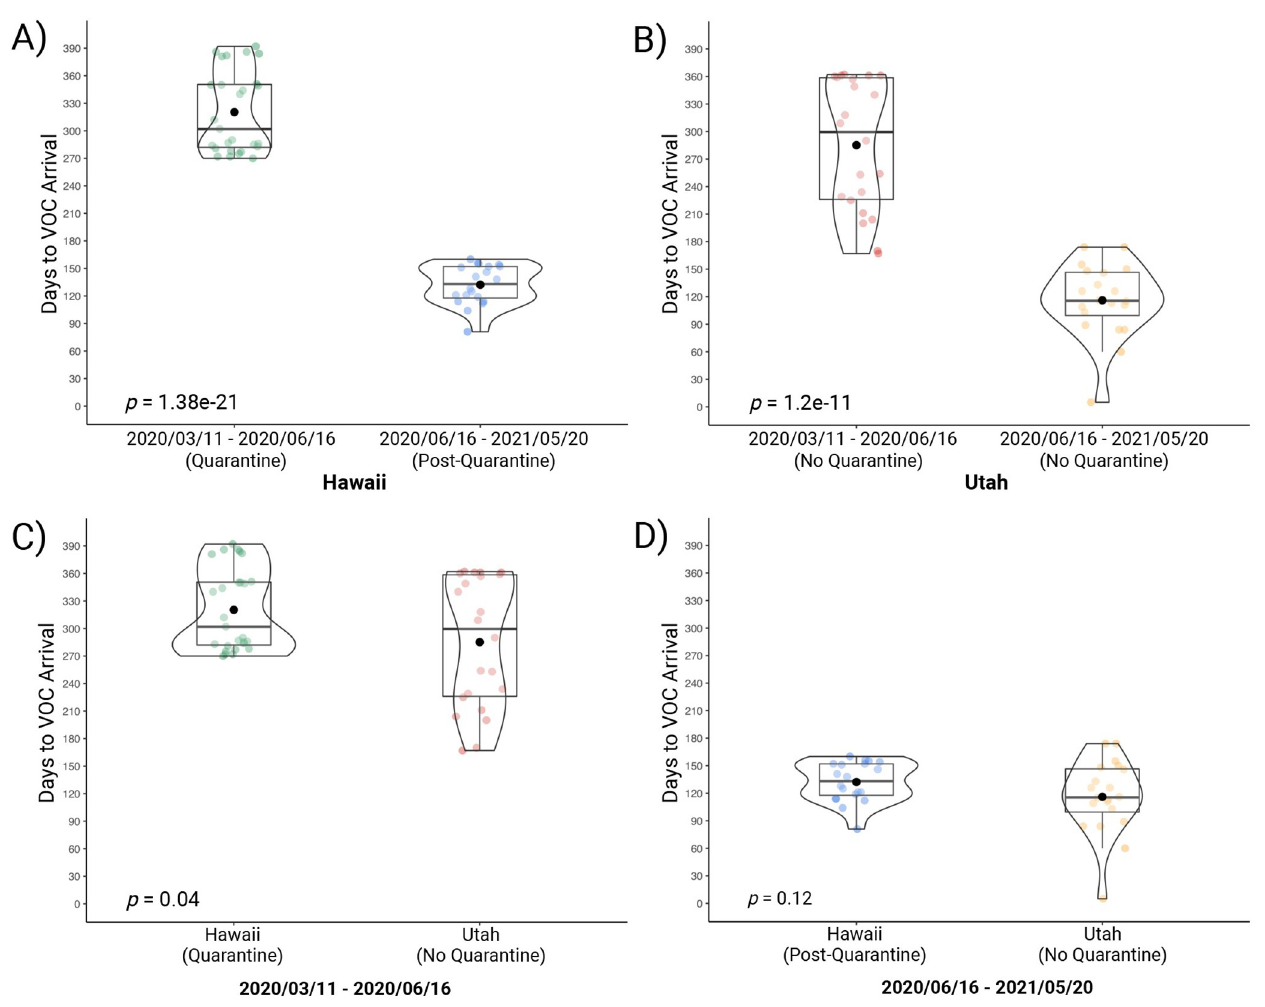
Fig 5. Post-quarantine days to VOC arrival vs. quarantine days to VOC arrival in Hawai’i and Utah as of May, 20, 2021. This figure shows the days-to- arrival of variants of concern (VOC) compared to VOC categorized as ‘quarantine’ and ‘post-quarantine.’ Depicted as a box-and-whisker/violin plot displaying median (line), mean (black circle), interquartile range, minimum, and maximum. Quarantine VOC are those VOC that emerged worldwide during the 43-state collective quarantine in the United States (2020-03-11 to 2020-06-16). Post-quarantine VOC are those VOC that emerged worldwide following the collective quarantine in the United States (2020-06-16 to 2021-05-20). The comparison was done using an independent t-test. A) Partitioning days to VOC arrival in Hawai’i into quarantine ( M = 320 days, SD = 45) and post-quarantine ( M = 132 days, SD = 21) time periods demonstrates that quarantine delayed the arrival of VOC to Hawai’i (t(45) = 17.38, p = 1.38e-21). B) For Utah, a state that did not quarantine during the 43-state collective quarantine, a difference is also demonstrated between the two time periods (quarantine M = 285 days, SD = 71; post-quarantine M = 116 days, SD = 40) regarding time to VOC arrival (t(40) = 9.37, p = 1.2e-11). C) Comparing Hawai’i and Utah by the quarantine time period demonstrates that Hawai’i ( M = 320 days, SD = 45), a quarantine state, saw a greater delay in days to VOC arrival compared to Utah ( M = 285 days, SD = 71), a non-quarantine state (t(47) = 2.11, p = 0.04). D) Comparing Hawai’i and Utah by the post-quarantine time period demonstrates no difference between Hawai’i ( M = 132 days, SD = 40) and Utah ( M = 116 days, SD = 40) (t(38) = 1.59, p = 0.12) in days to VOC arrival. Created with RStudio version 1.3.1093 (R version 4.0.3) using ggplot2 and ggstatsplot packages. The final figure was created with